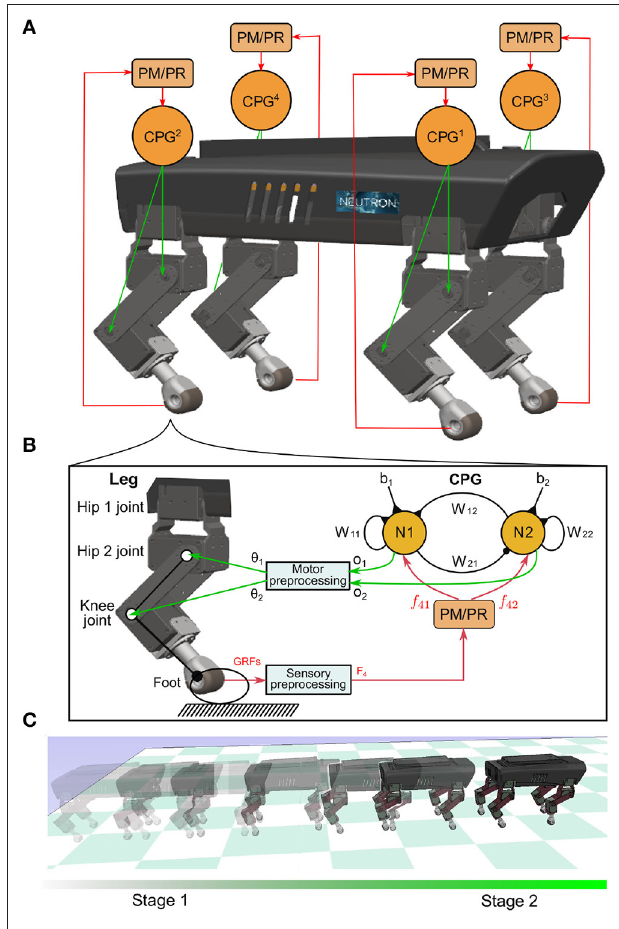
FIGURE 1 | (A) Four identical and decoupled neural SO (2)-based CPGs modulated by the PM or PR relying on the sensory feedback (i.e., GRFs). They are used to control a quadruped robot. (B) Each CPG is composed of two mutually connected neurons. It outputs two synchronized signals ( o 1,2 ). The signals are linearly re-scaled as motor commands ( θ 1,2 ) for controlling the hip 2 and knee joints of a leg through the motor preprocessing unit. For simplicity, here the hip 1 joint is kept fixed and set to a certain position. (C) The quadruped was demonstrated under the self-organized locomotion generation process. The process was divided into two stages: transition (Stage 1) and formation (Stage